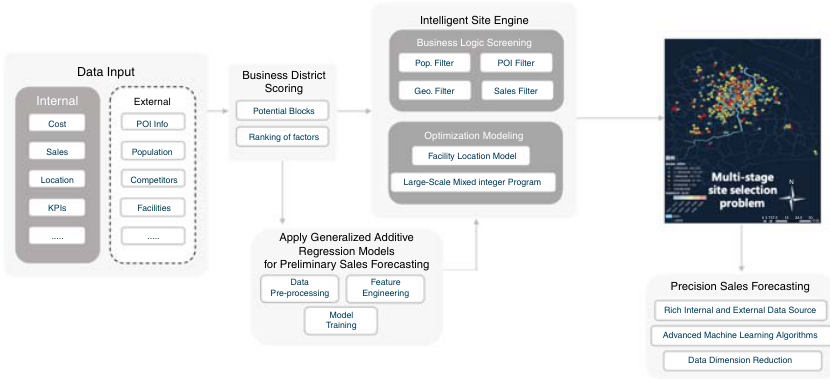
Figure 1. An overview of the intelligent site selection